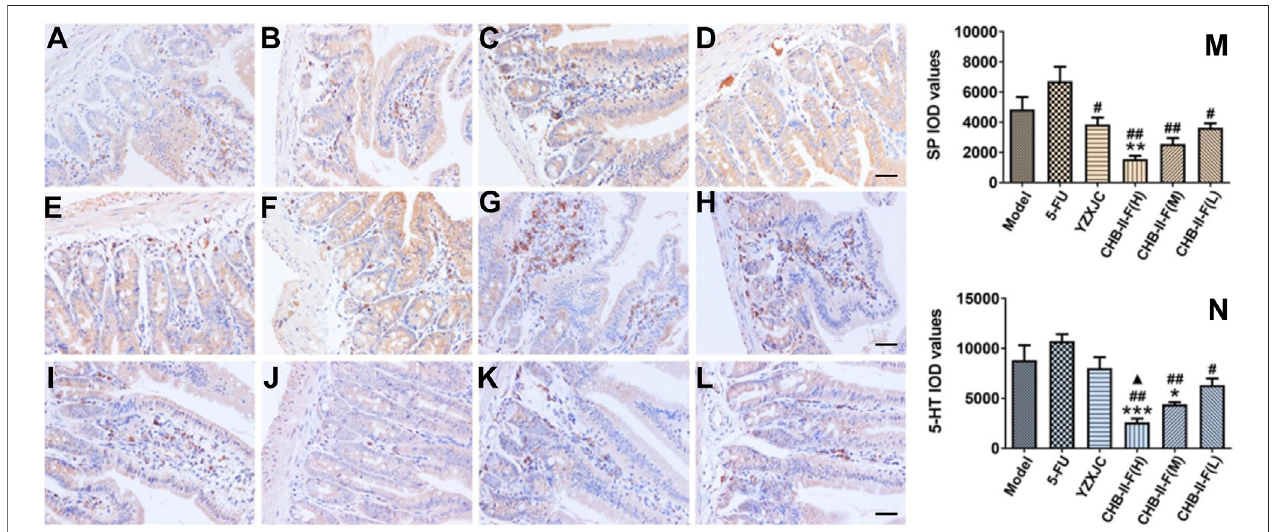
FIGURE 8 | Effects of CHB-II-F on protein expression of SP and 5-HT in the duodenum of the transplanted H 22 hepatocellular carcinoma model mice receiving chemotherapy detected by immunohistochemistry ( x ± s , n (cid:2) 6). (A – F) Immunohistochemical pictures of SP protein expression in duodenum in saline-treated controls (model), 5-FU treated controls (0.02 g/kg), YZXJC (0.78 g/kg), CHB-II-F(H) (65 g/kg), CHB-II-F(M) (32.5 g/kg), and CHB-II-F(L) (16.25 g/kg), respectively ( × 400, scale bar (cid:2) 200 μ m). (G – L) Immunohistochemical pictures of5-HT protein expression induodenum insaline-treated controls(model),5-FU treated controls (0.02 g/kg), YZXJC(0.78 g/kg),CHB-II-F(H)(65 g/kg),CHB-II-F(M)(32.5 g/kg),andCHB-II-F(L)(16.25 g/kg),respectively( × 400,scalebar (cid:2) 200 μ m). (M) SPIODvaluesindifferent groups. (N) 5-HT IOD values in different groups. Statistical analysis: * p < 0.05, ** p < 0.01, *** p < 0.001 compared with the model (saline) group. # p < 0.05, ## p < 0.01 compared with the 5-FU group. ▲ p < 0.05 compared with the YZXJC group.